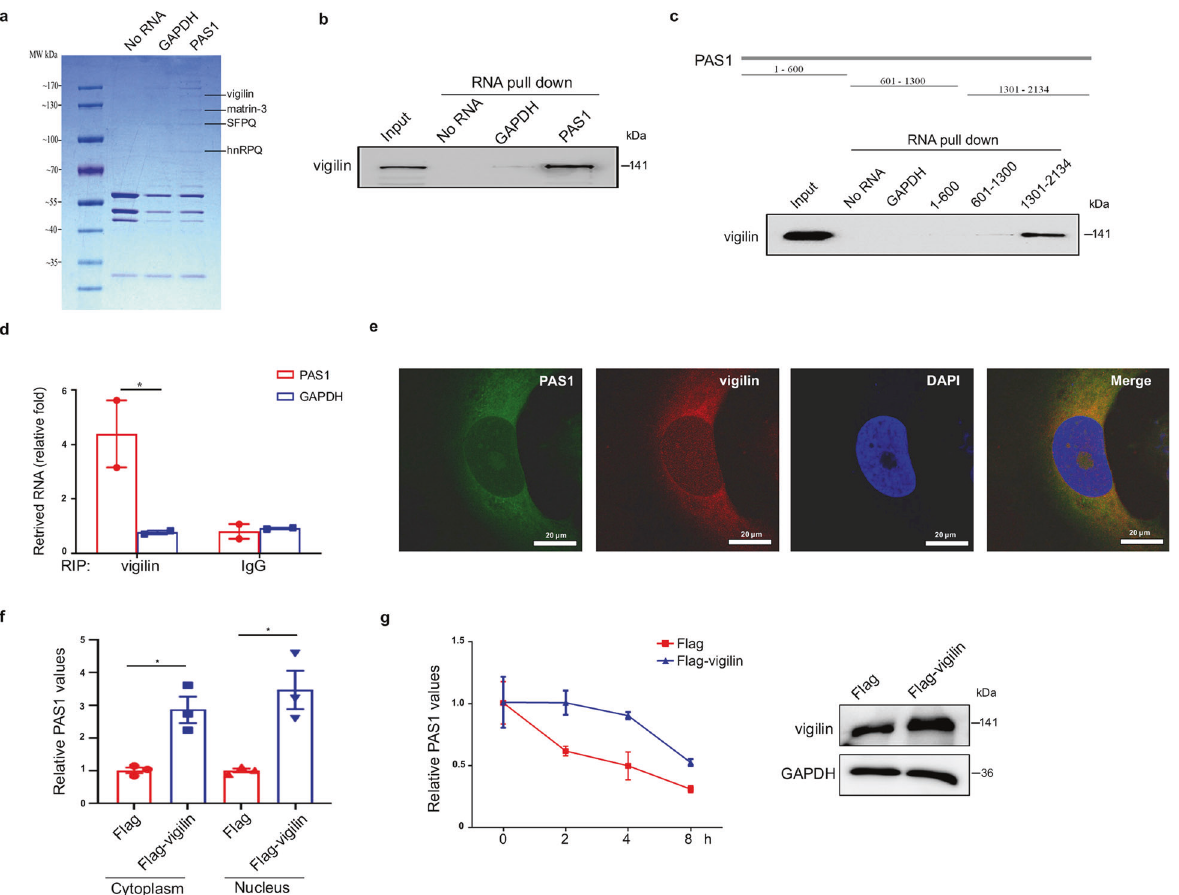
Fig. 3 Vigilin interacts with PAS1 and maintains its stability. a RNA pull down combined with mass spectrometry was performed using biotin- labeled PAS1 RNA. Biotin-labeled GAPDH mRNA were used as negative controls. b Biotin-labeled PAS1 and GAPDH were incubated with lysates from MCF7 cells, followed by RNA pull down. c Biotin-labeled RNAs containing different regions of PAS1 were designed. RNA pull down was performed by incubating biotin-PAS1 fragments with MCF7 cell lysates. d RIP assay was performed with anti-vigilin antibodies. RIP enrichment was determined as the amount of RNA recovered in association with vigilin, relative to that recovered with an IgG control. Data are mean ± SEM by two-tailed t test. * p < 0.05. e Co-staining of PAS1 (RNA FISH, Alexa Flour 488), vigilin (immuno fl uorescence, Alexa Flour 568) and nuclei (DAPI) in Hs578T cells. f Flag or Flag-vigilin was transfected into Hs578T cells and both cytoplasmic and nuclear RNA was then extracted for qRT-PCR. Data are mean ± SEM by t test. g Flag or Flag-vigilin was transfected into Hs578T cells. After 48 h, cells were treated with 20 μ g/ml ActD. Total RNA was extracted at different time point for qRT-PCR. Data are mean ± SD by t test. Pro t ein was extracted at 0 h for Western